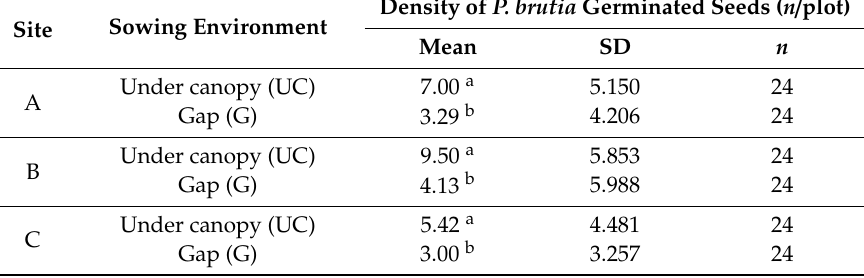
Table 2. Mean density of P. brutia germinated seeds in the late sowing period (LSP–February) in the plots that were established in the under canopy and in gap sowing environments (averaged over the two levels of the factor ‘water supplementation’) in each of the three sites (‘sowing environment’ main effect). Site Sowing Environment